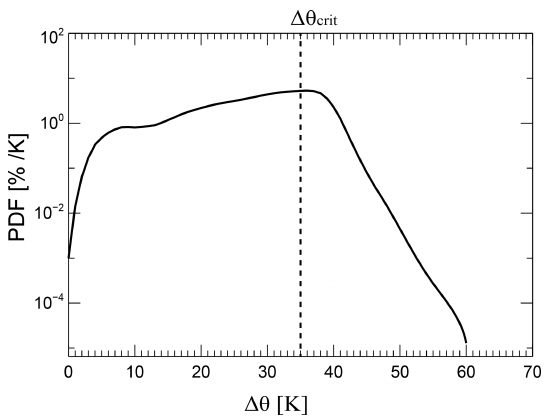
Figure 6. The probability distribution function (PDF, in units of %K − 1 ) of convective uplift (cid:49)θ in the tropics (30 ◦ S-30 ◦ N) for the air parcels in the lowest level of CLaMS ( (cid:49)ζ = 250K, (cid:49)z ≈ 1 . 4– 2km) where N 2 m is negative using the ERA-Interim reanalysis data of the year 2005. The restriction for the deep convection scheme ( (cid:49)θ > (cid:49)θ crit = 35K) is marked as the dashed straight line.